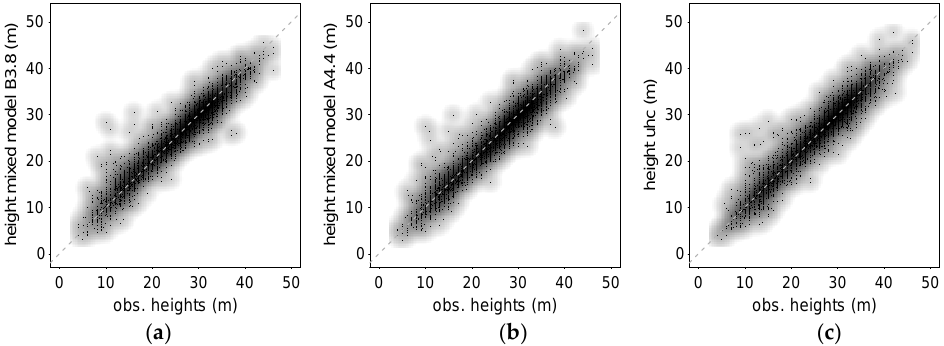
Figure 2. Predicted heights against observed heights. Smoothed densities of the corresponding scatterplots derived through two-dimensional kernel density estimates. The light-gray dashed line is the reference line with zero intercept and slope one. ( a ) Model B3, Calibration Strategy 8; ( b ) Model A4, Calibration Strategy 4; and ( c ) uhc model.